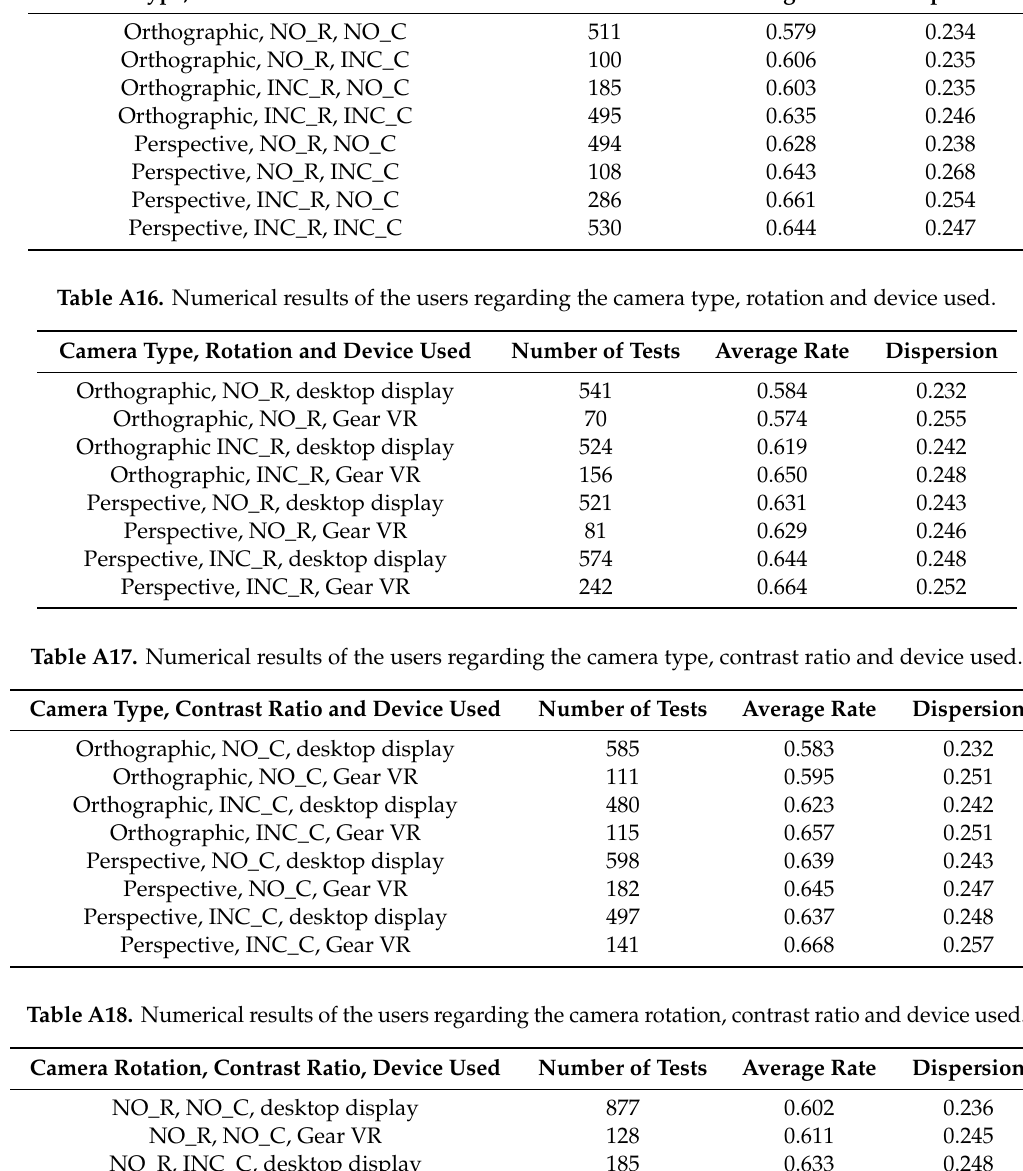
Table A15. Numerical results of the users regarding the camera type, rotation and contrast ratio. Camera Type, Rotation and Contrast Ratio